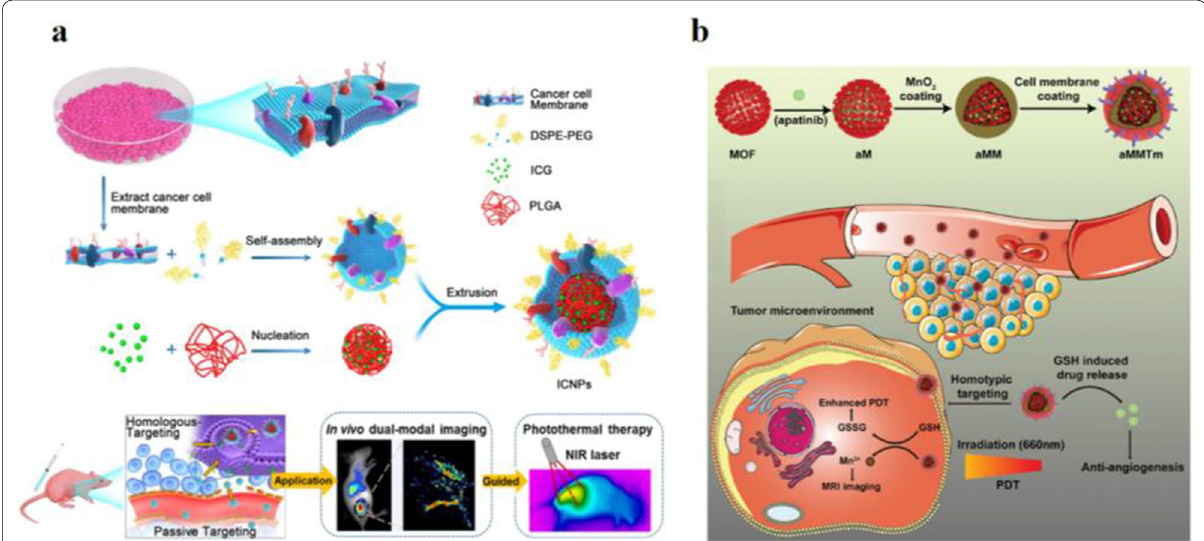
Fig. 2 a Illustration of the cancer cell membrane-biomimetic ICNPs nanoparticles for targeting recognition of source cancer cell, dual-modal imaging, and photothermal therapy [35]. Copyright 2016 American Chemical Society. b Schematic illustration of aMMTm preparation and proposed combination therapy of PDT and antiangiogenesis [37]. Copyright 2019 WILEY–VCH Verlag GmbH & Co. KGaA,